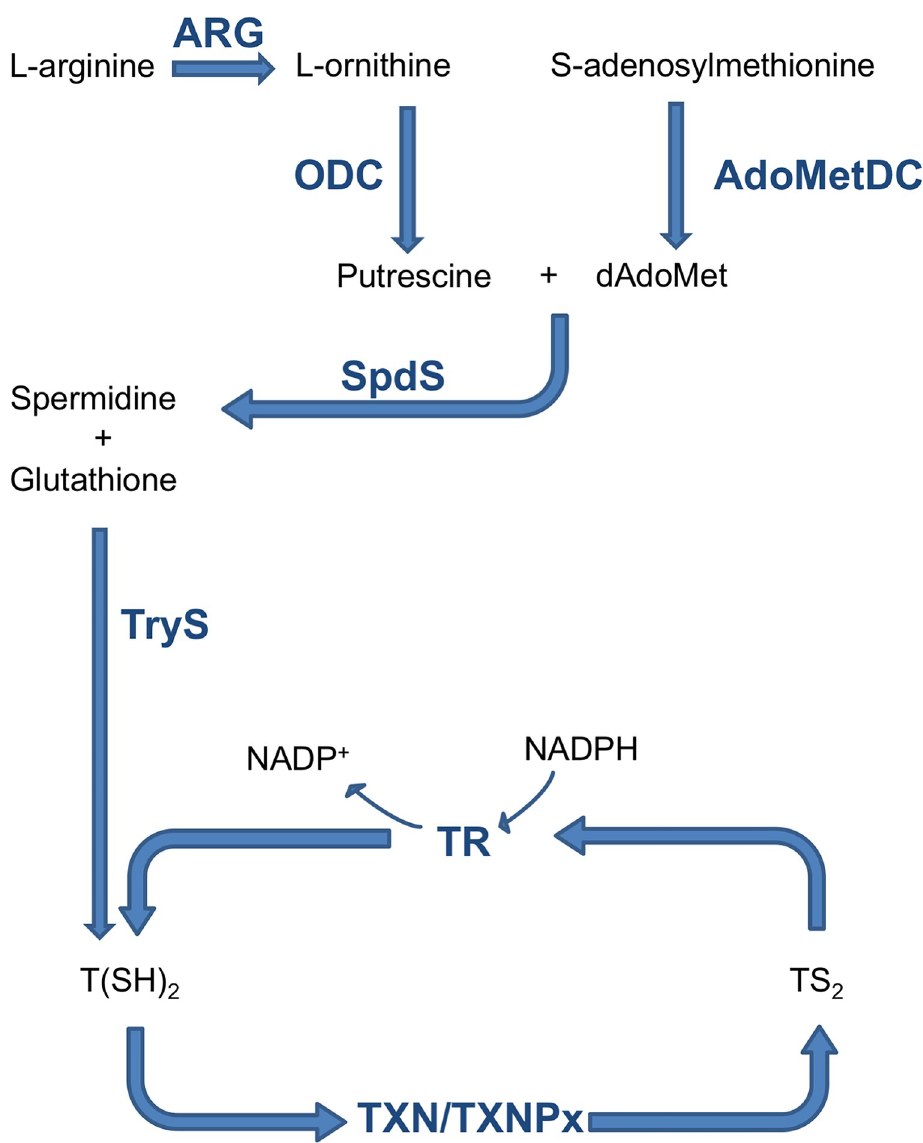
Fig 1. Schematic representation of the trypanothione